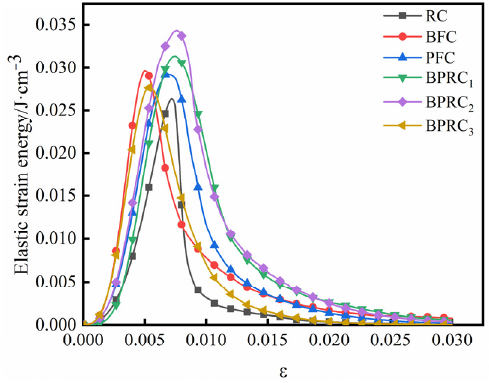
Figure 9. Elastic strain